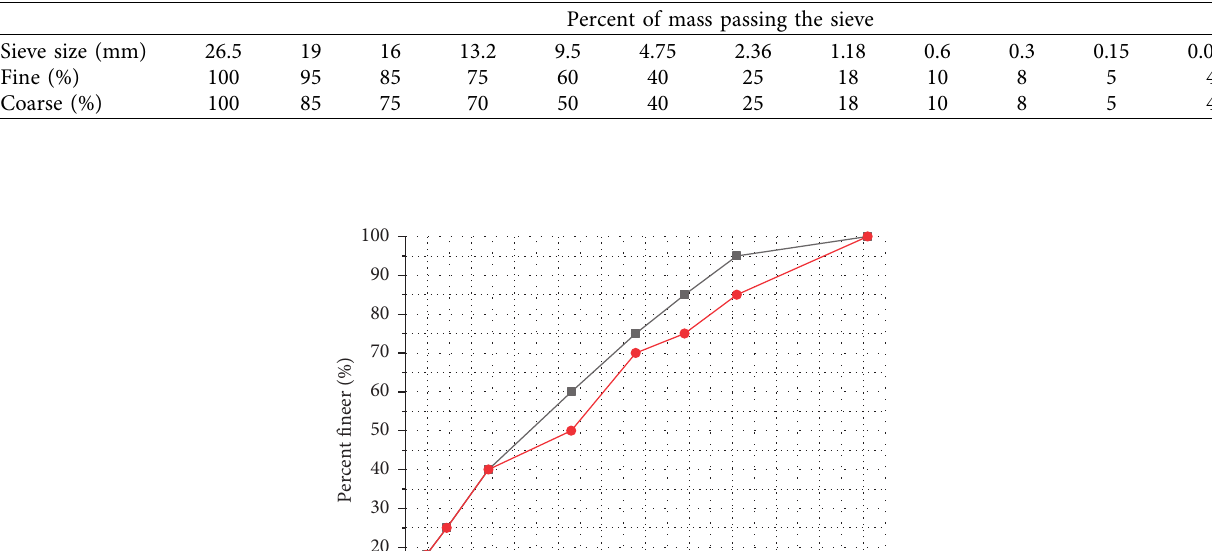
Table 1: Gradation of aggregate.